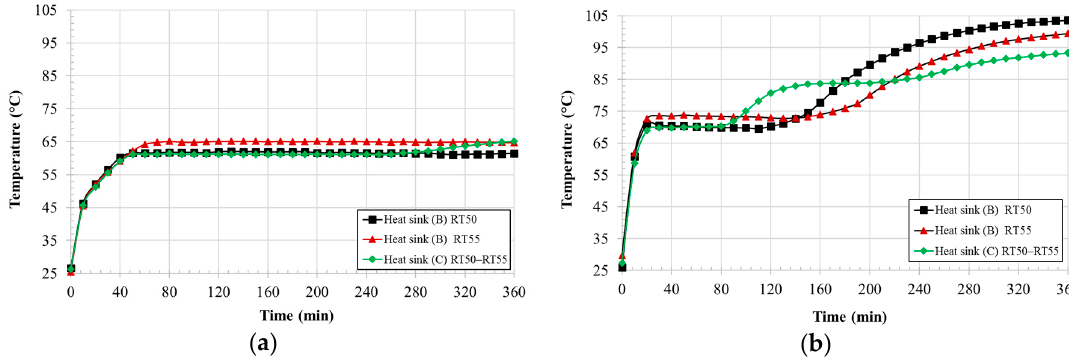
Figure 12. Surface heat sink temperature of one and two PCM heat sinks for different PCMs at power rating of, ( a ) 1.0 W and ( b ) 2.0 W. rating of, ( a ) 1.0 W and ( b ) 2.0